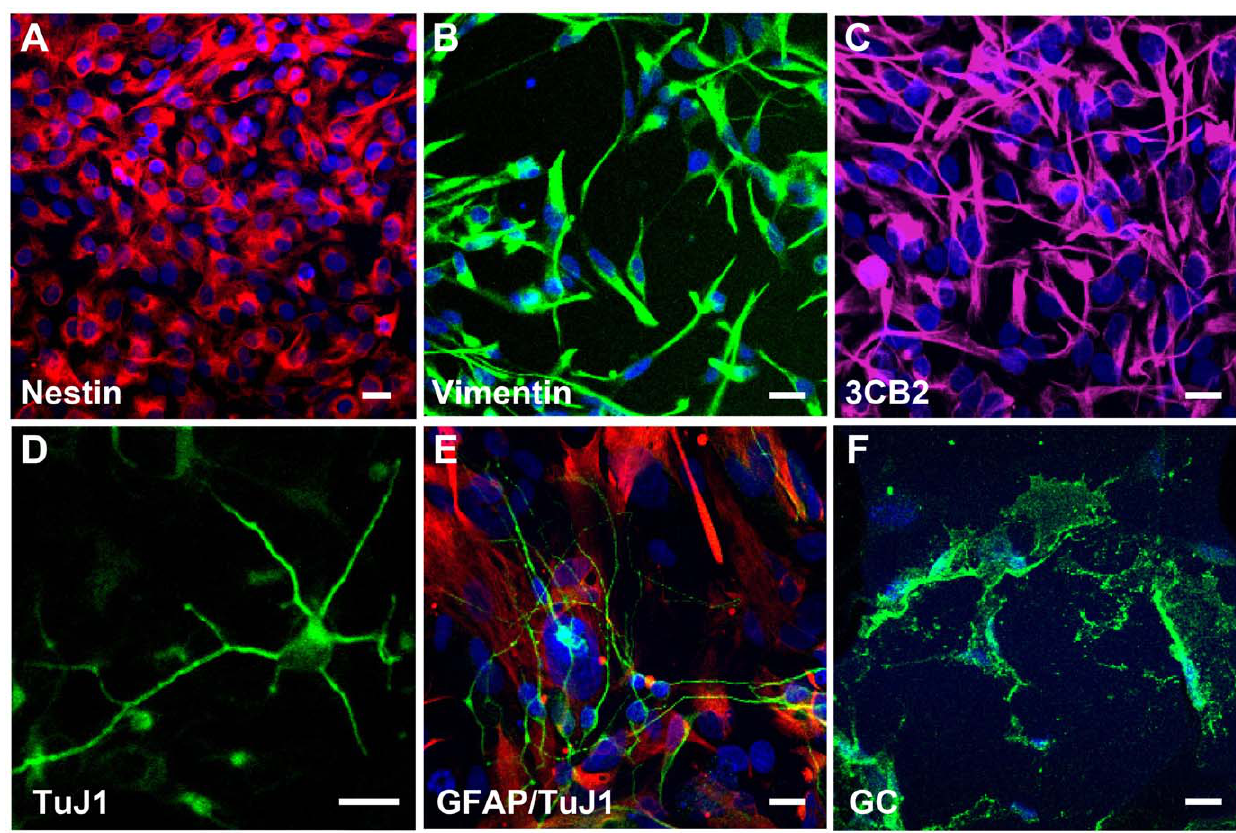
Figure 1. The hNSCs uniformly express markers of neural stem cells. The isolated hNSCs were passaged every 5–7 days, as described in the Methods section. They grew as a stable homogenous monolayer and uniformly expressed molecular features of NSCs. The top 3 panels: A, B, C represent photomicrographs of undifferentiated hNSCs immunostained with the neural precursor markers nestin (red, A) and vimentin (green, B) and the radial glial marker 3CB2 (purple, C). The cultures were counterstained with the nuclear DNA marker 4 9 ,6-diamidine-2 9 -phenylindole dihydrochloride (DAPI, blue). The bottom panels (D, E, F) show 7-day old differentiated hNSC cultures processed for indirect immunocytochemistry. Differentiated hNSCs expressed the neuronal-specific marker TuJ1 (green D, E), the astroglia marker GFAP (red, E), the oligodendroglial marker GC (green, F) and DAPI, blue nuclei in all panels. Cell nuclei were stained with live cell marker DAPI (blue, F, G). Scale bars are 20 m m (A–F).